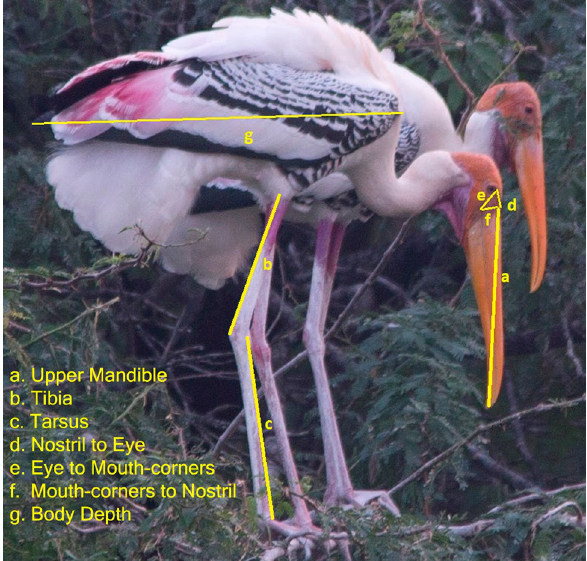
Figure 3. The digital image of Painted Storks and their selected morphological variables are shown on the bottom left. The length of the Upper Mandible marked in yellow as ‘a’ is 21 cm; details of other morphological variables are explained in the text (“Measurements of the morphological variables”).